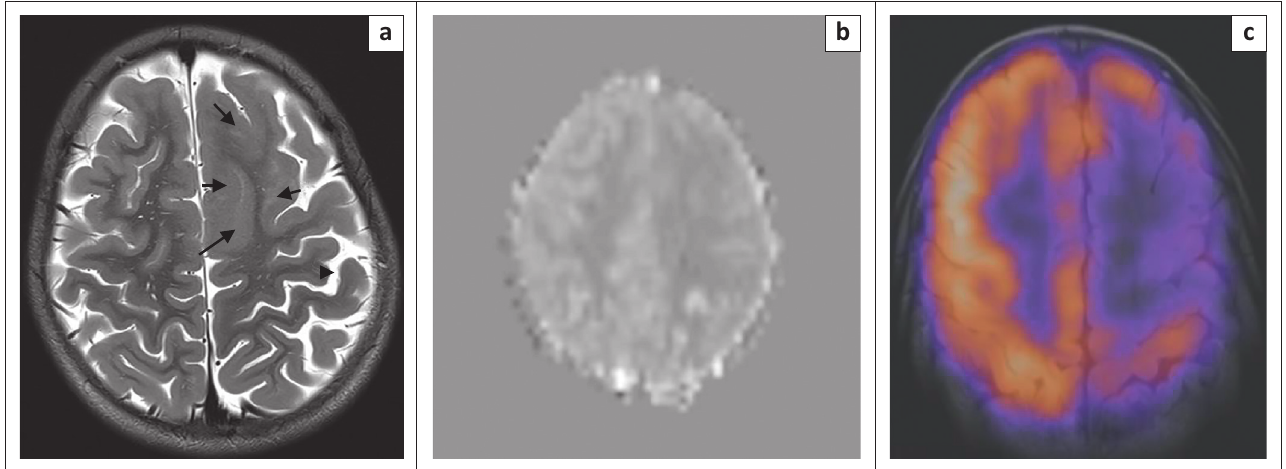
FIGURE 11: Six-year-old boy presented with intractable seizures and left fronto-central EEG abnormality. Axial T2W (a) shows cortical thickening in the left frontal lobe (arrows). This is matched by hypoperfusion on the regional cerebral blood flow (reCBF) map (b) from the pulsed ASL acquisition and by decreased uptake of FDG on the PET scan